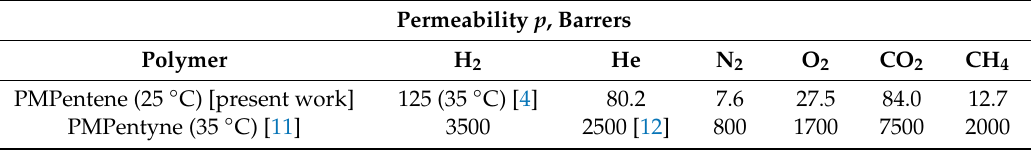
Table 1. Permeability coefficients of PMPentene and PMPentyne in relation to certain gases. Permeability p , Barrers